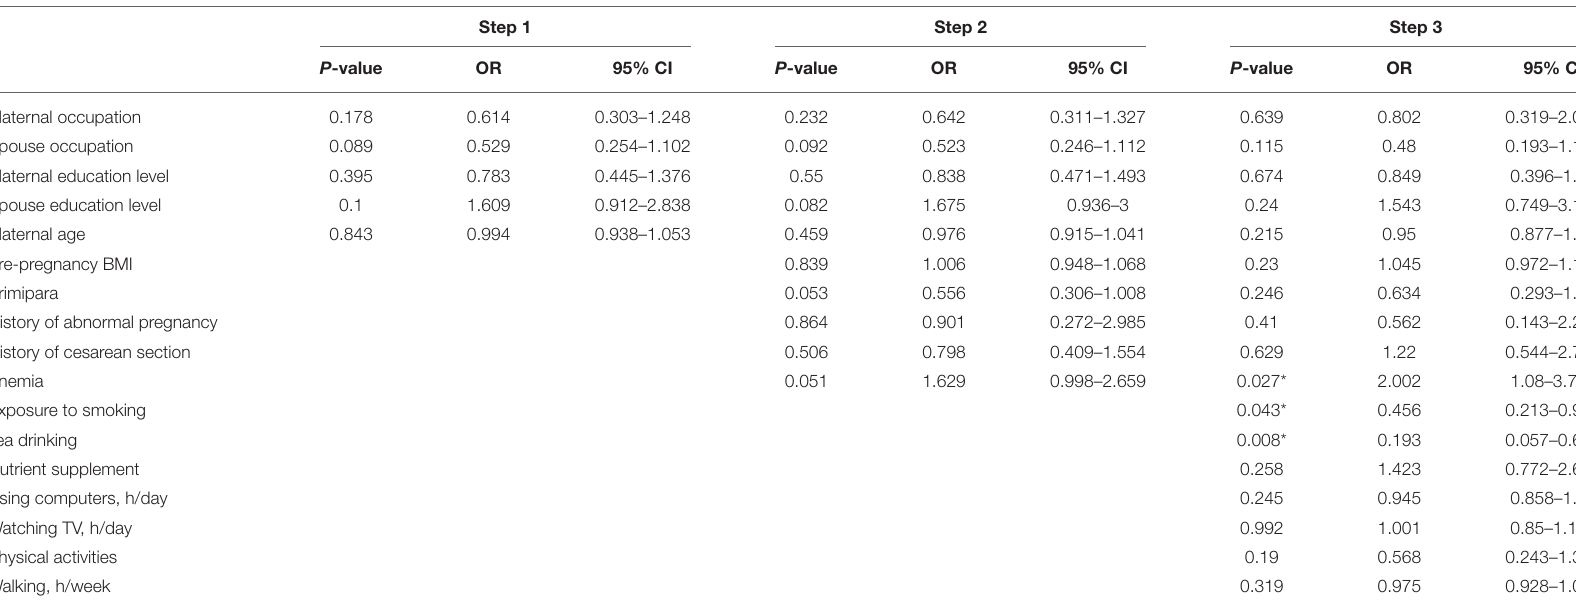
TABLE 5 | Hierarchical logistic regression predicting adverse pregnancy outcomes from sociodemographic features, medical records and life behaviors, China,